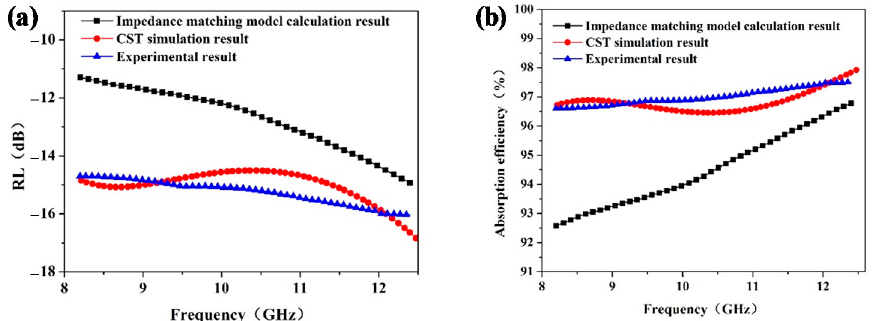
Figure 5. Reflection loss ( a ) and corresponding microwave absorption efficiency ( b ) of the impedance matching model calculation result, CST simulation result, and experiment result.